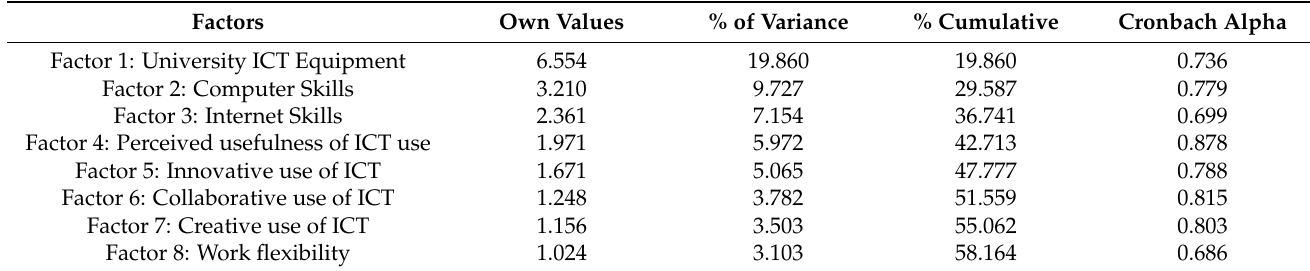
Table 4. Factors retained and variance explained.